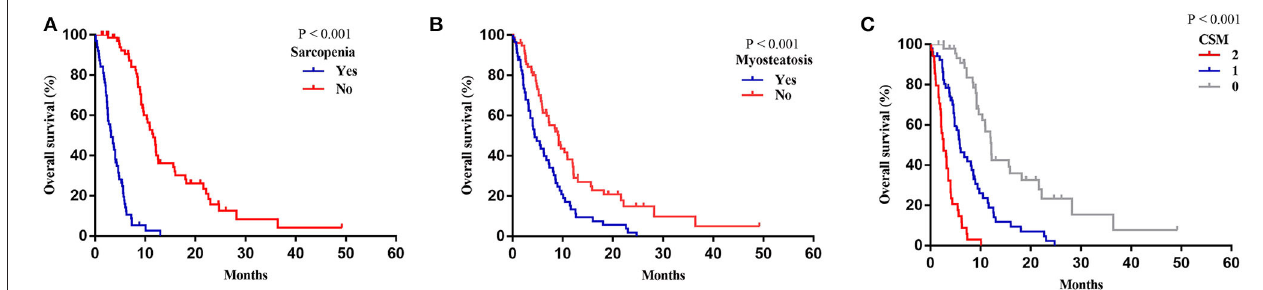
FIGURE 5 | Overall survival based on sarcopenia, myosteatosis, and CSM. (A) Sarcopenia. (B) Myosteatosis. (C) CSM.